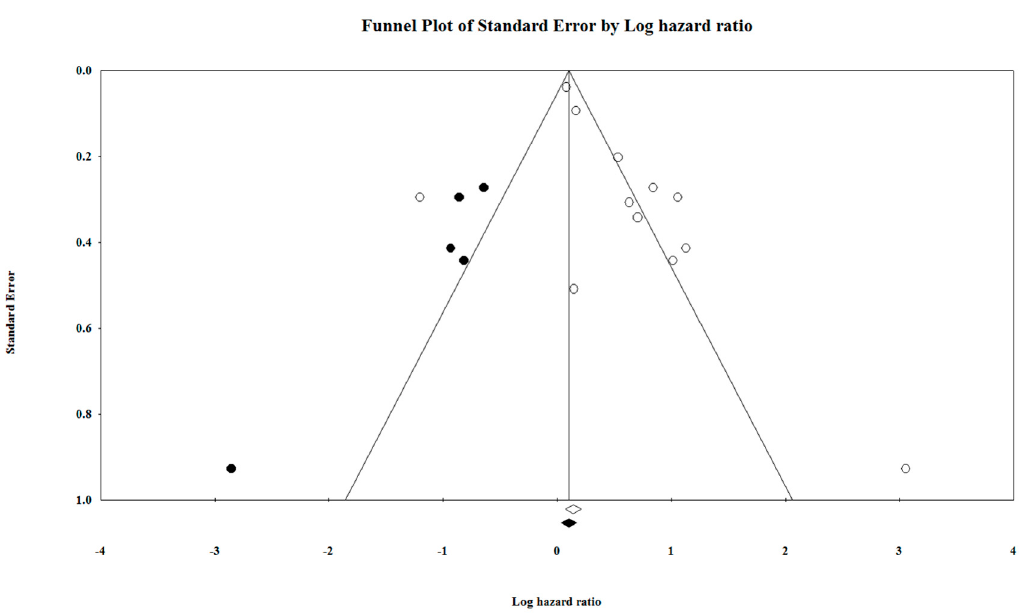
Figure 7. Funnel plot of studies including the imputed studies in our meta-analysis.